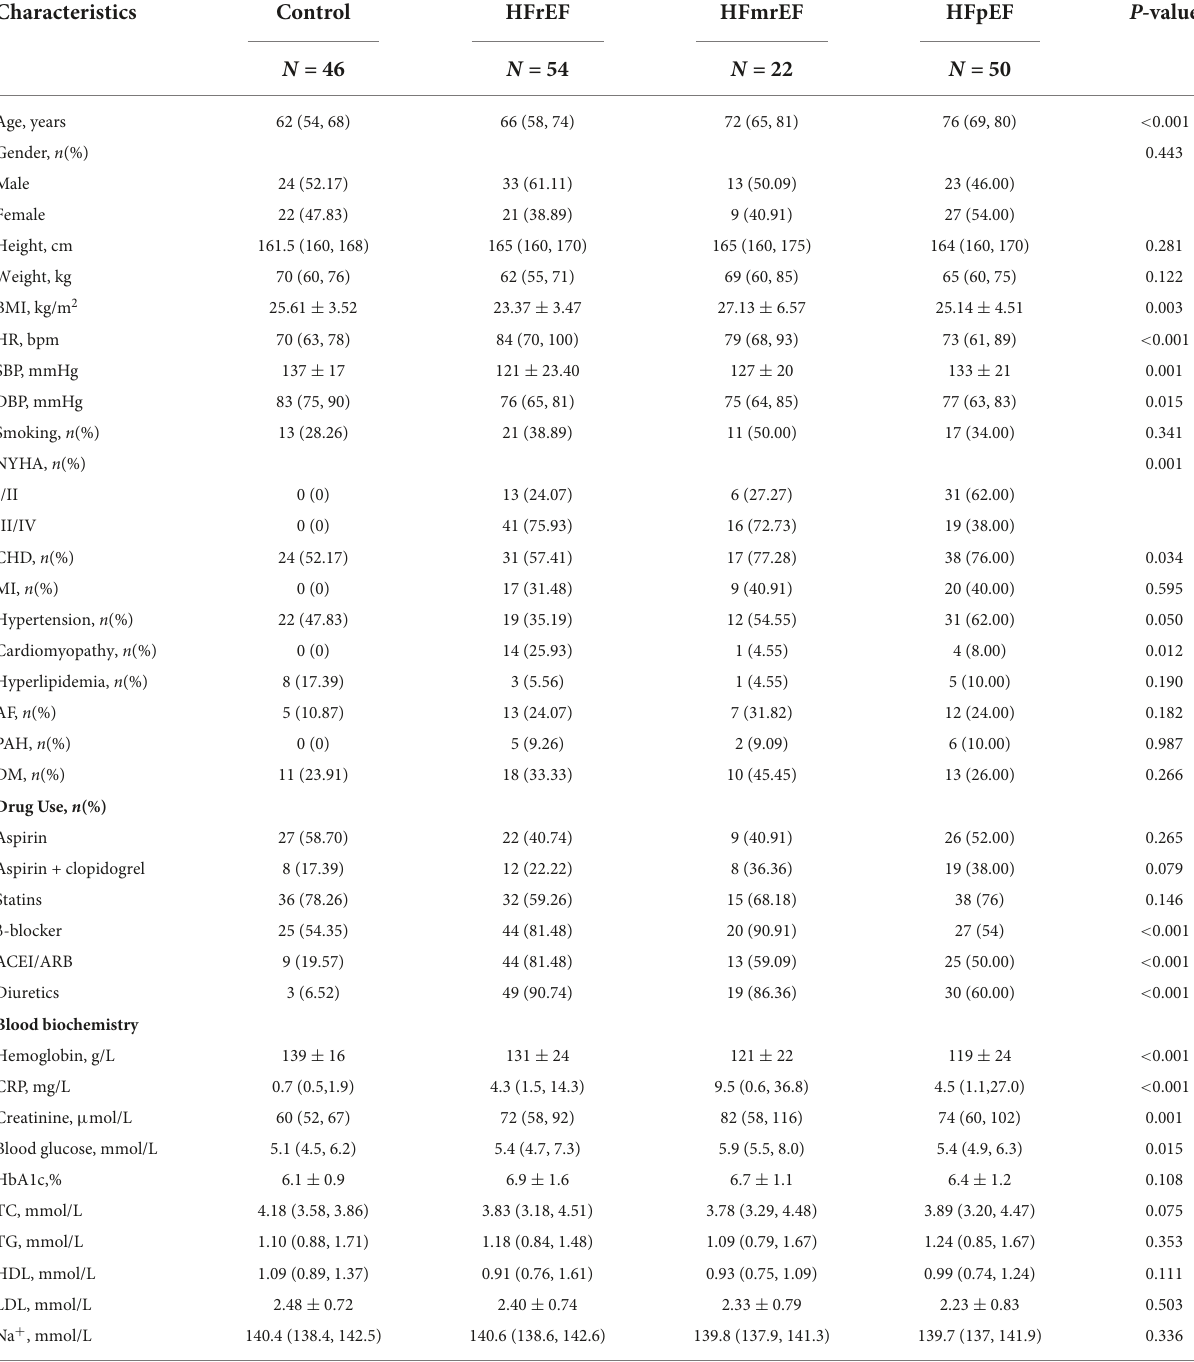
TABLE 3 Main characteristics of the study